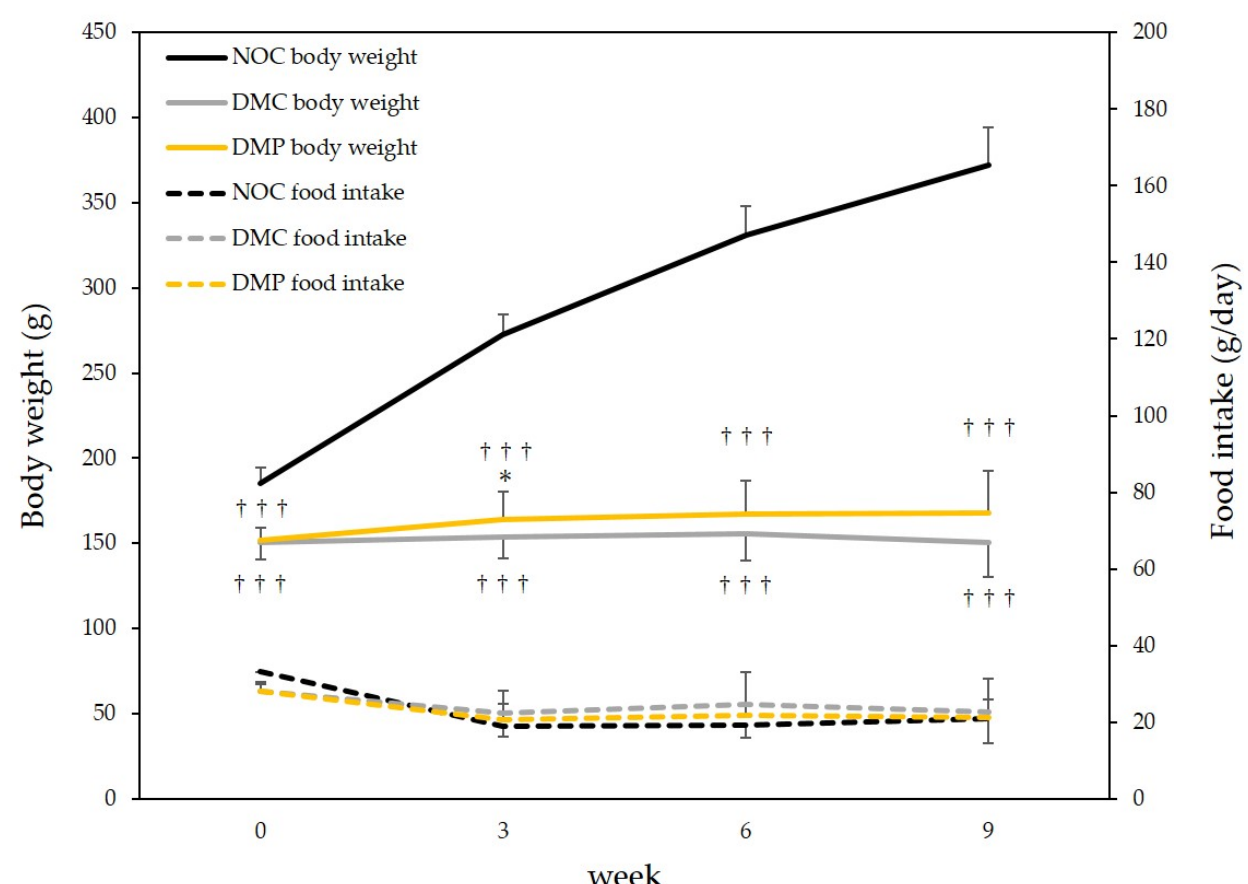
Figure 2. Changes in food intake and body weight in normal and diabetic rats. NOC: normal rats fed a control diet, DMC: diabetic rats fed a control diet, DMP: diabetic rats fed non-extractable fraction of dried persimmon (NEP) diet. Data are presented as the mean ± SD of each animal in each group. * p < 0.05 significantly different from the DMC group. ††† p < 0.001 significantly different from the NOC